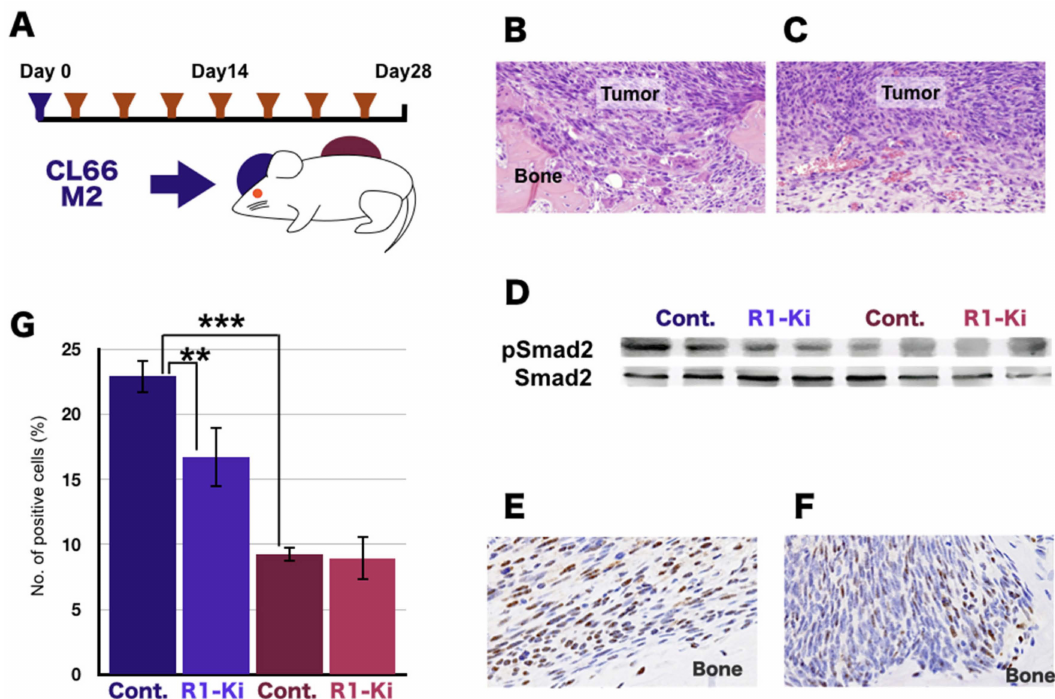
Figure 1. Suppression of TGF- β signaling by TGF- β receptor kinase inhibitor in the bone microenvironment (micro-E). ( A ) Experimental design: mouse mammary tumor cell line was implanted intotwodi ff erentsitesinfemalemice, underthedorsalskinflapoverthecalvariaandintoasubcutaneous lesion. Then the mice were injected intraperitoneously seven times with a TGF- β receptor 1 kinase inhibitor (R1-Ki) over the course of the experimental period. ( B ) Typical examples of tumor tissue in the bone micro-E. Strong osteolysis associated with induction of numerous osteoclasts was observed in the bone micro-E. Magnification: 600 × . ( C ) Typical example of the tumor cells in the subcutaneous (subQ) micro-E; growth of the tumor cells was observed with micro vessel invasion. Magnification: 600 × . ( D ) Western blot analysis of the expression of phosphorylated-SMAD2, and SMAD2. ( E , F ) IHC staining of pSMAD2: Many positive cells were observed in the control group ( E ) and a smaller number of positive cells were in the R1-Ki treatment group in the bone micro-E ( F ).